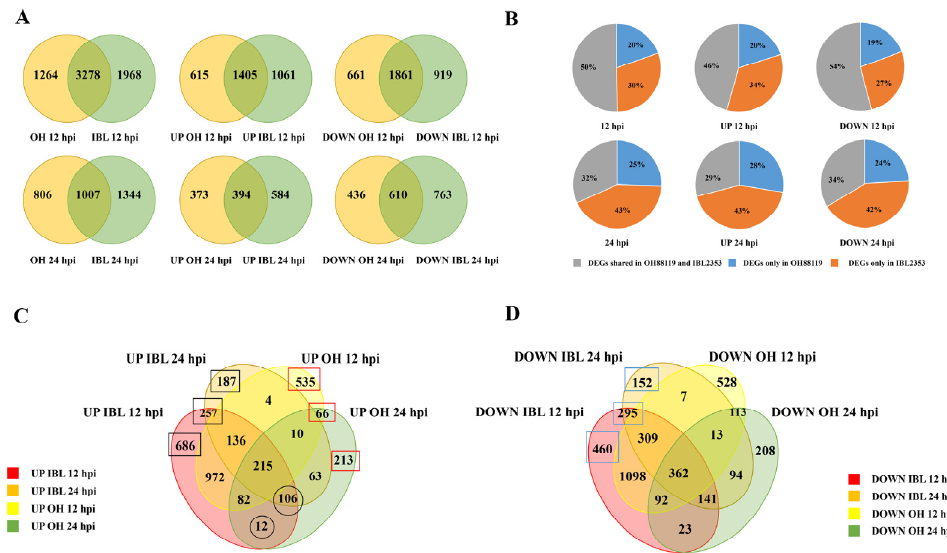
Figure 2. Venn diagrams showing DEG contrasts between resistant IBL2353 and susceptible Ohio88119. ( A ) Venn diagram representation of overlapping DEGs quantity between two tomato lines. ( B ) The pie chart representation of the proportion of DEGs shared in Ohio88119 and IBL2353. ( C ) Comparison of up-regulated DEGs between IBL2353 and Ohio88119 at 12 and 24 hpi. ( D ) Com- parison of down-regulated DEGs between IBL2353 and Ohio88119 at 12 and 24 hpi. UP and DOWN herein are the abbreviation of up-regulated and down-regulated, and IBL and OH herein are the abbreviation of IBL2353 and Ohio88119.